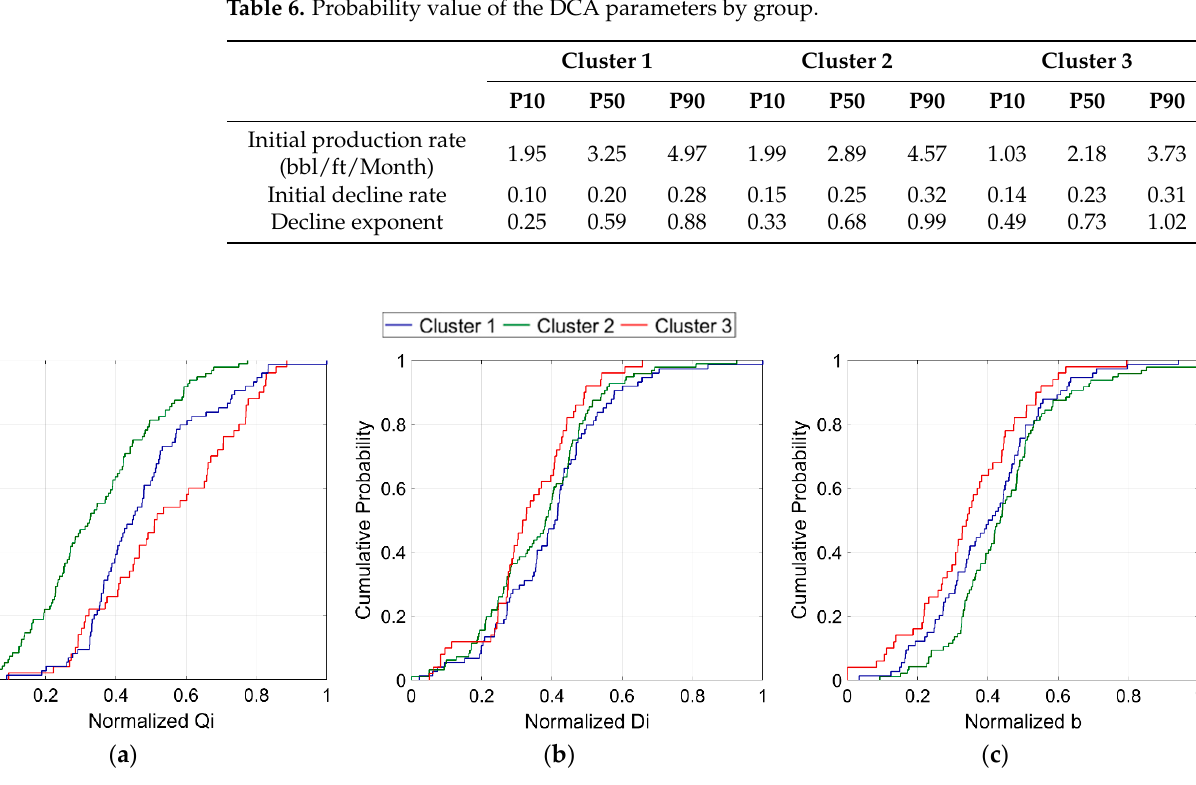
Figure 18. Cumulative probability of the DCA parameters by group: ( a ) Cluster 1; ( b ) Cluster 2; ( c ) Cluster 3.